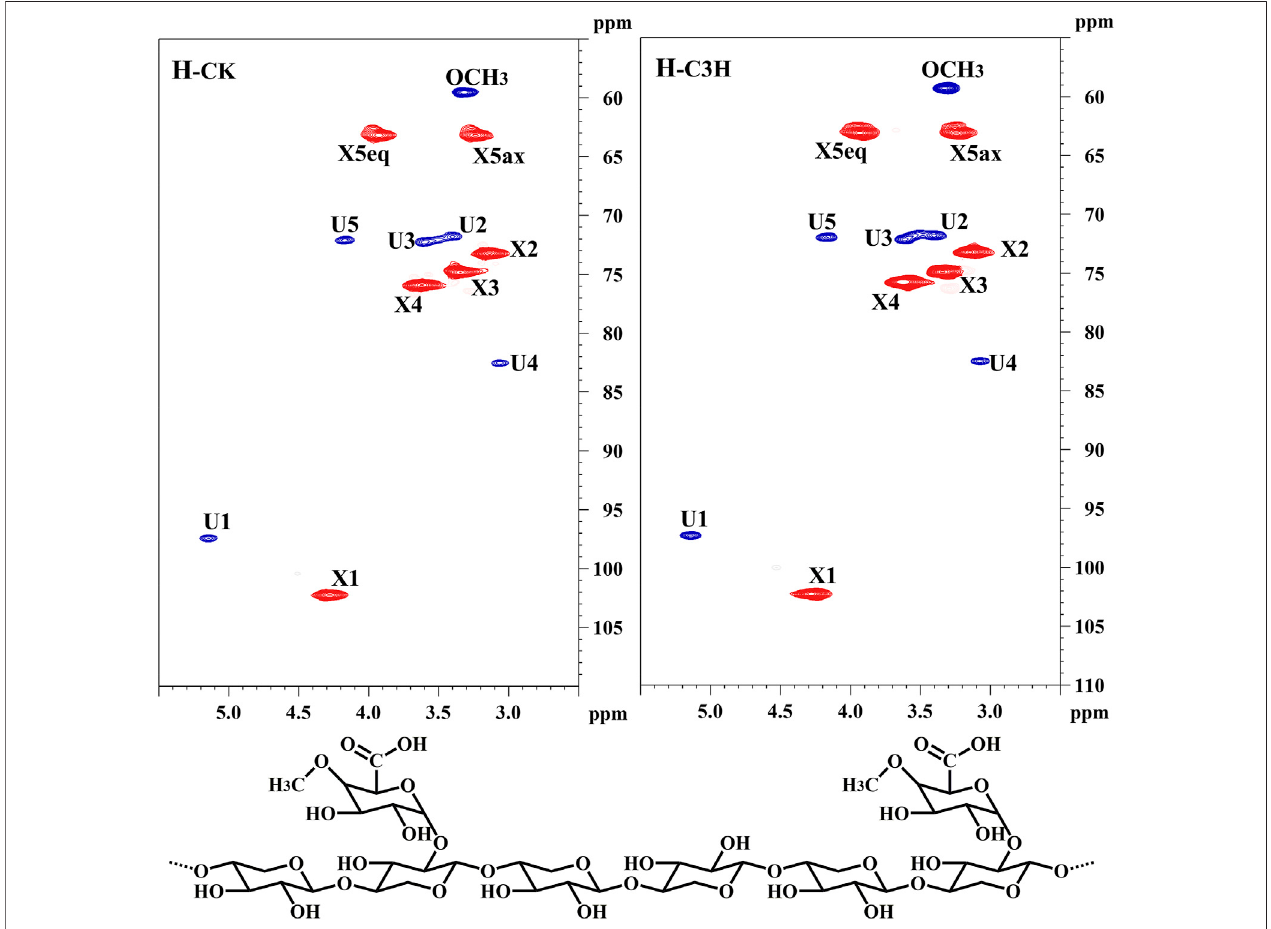
FIGURE 3 | 2D-HSQC spectra and conjectural structures of the